Question: Which kind of chart has been used to present this data?
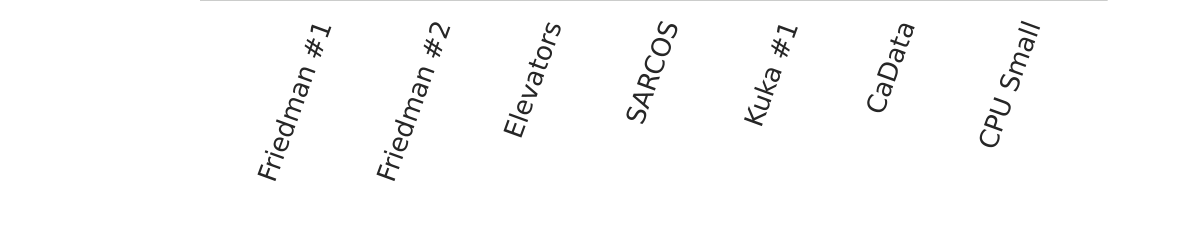
Answer: bar